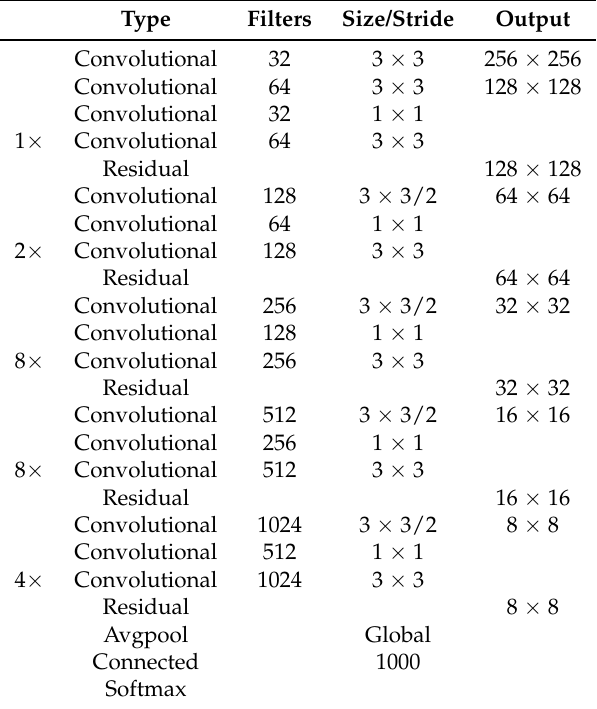
Table 3. YOLO version 3 Network’s Architecture Darknet-53